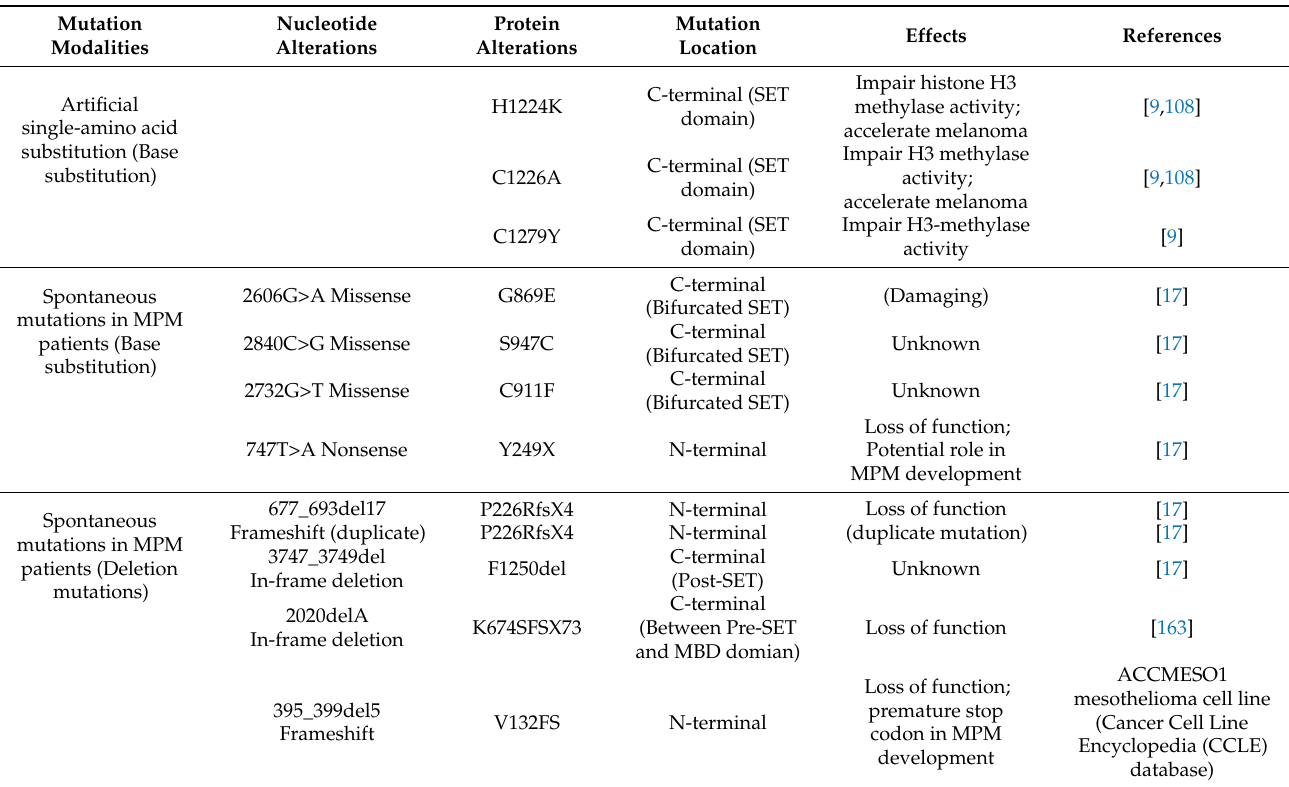
Table 2. Mutations of SETDB1 and deleterious